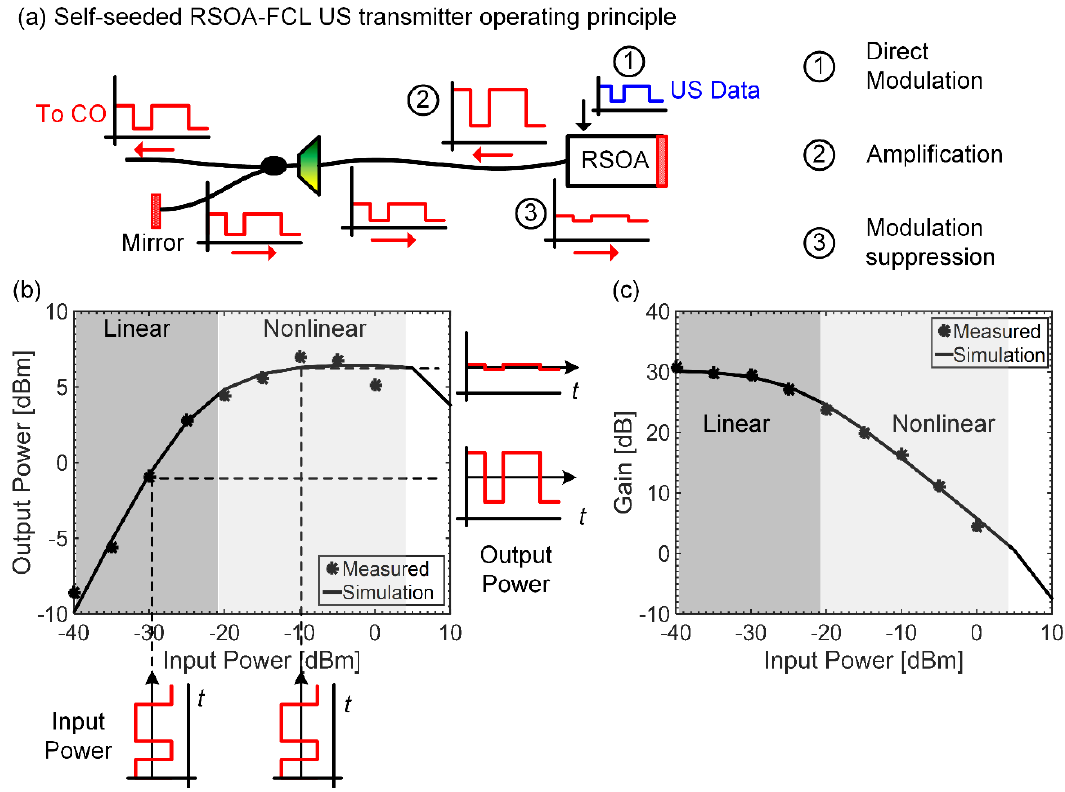
Figure 3. Operation principle of the RSOA-FCL. ( a ) RSOA-FCL with the three functions of the RSOA: (1) direct modulation; (2) amplification and (3) modulation suppression; ( b ) Output power and ( c ) gain vs. input power for RSOA. The RSOA static